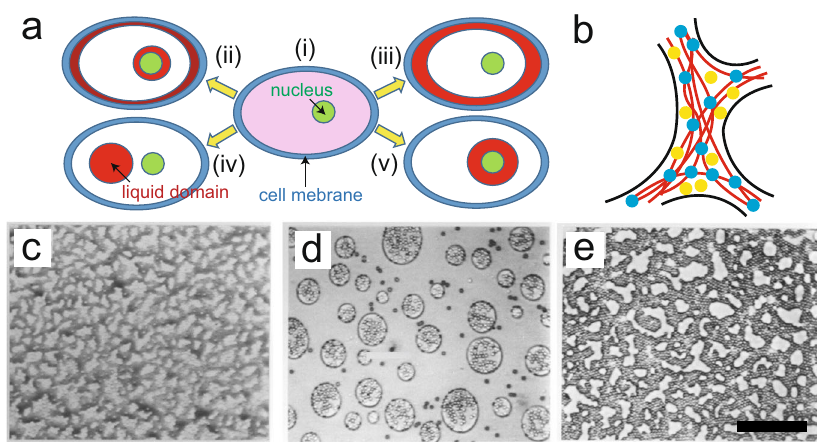
Fig. 5 Wetting effects on biological phase separation. a Schematic picture showing the possible wetting effects on phase separation in a cell surrounded by the cell membrane and containing a nucleus. Here we consider only the cell wall (blue) and nucleus (green) as elastic components for simplicity. The pink liquid con fi ned in the cell (image (i)) phase separates into the red and white liquid phases. For such a case, there can be four possible situations. Image (ii): The red liquid phase wets both the cell membrane and nucleus. Image (iii): The red liquid phase wets only the cell membrane. Image (iv): The white liquid phase wets both the cell membrane and nucleus. Image (v): The red liquid phase wets only the nucleus. b Schematic picture of coexistence of immobile polymers (red) connected by binding proteins (blue) and mobile proteins (yellow) in a network structure. c Phase separation in a binary liquid mixture (oligo-caprolactone/oligo-styrene (3/7)) containing immobile glass beads (diameter = 7 μ m and volume fraction = 9%). The phase-separation pattern was observed after 600 s from a temperature quench from 140 to 100 °C. d Phase separation in the same binary liquid mixture containing mobile glass beads (diameter = 7 μ m and volume fraction = 3.2%). The phase-separation pattern was observed after 1710 s from a temperature quench from 140 to 60 °C. e Phase separation in the same binary liquid mixture containing mobile glass beads (diameter = 7 μ m and volume fraction = 19%). The phase- separation pattern was observed after 3180 s from a temperature quench from 140 to 60 °C. The high particle density con fi ned in the more wettable phase makes the dynamics glassy. The black bar corresponds to 100 μ